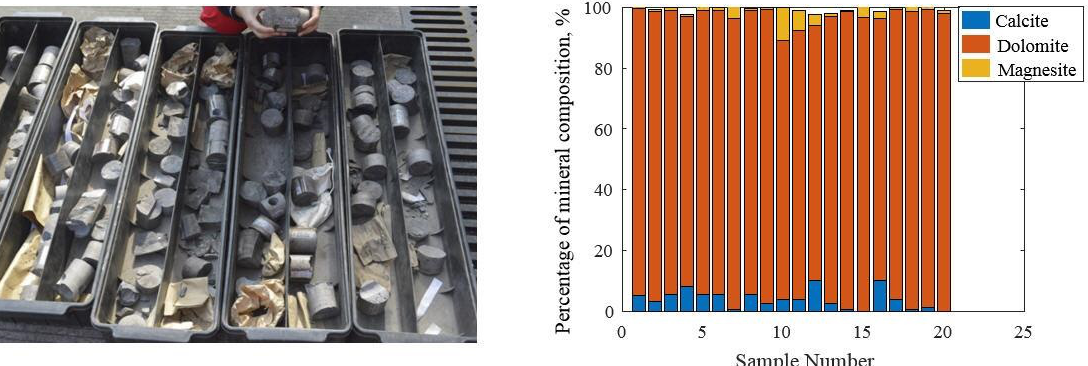
Figure 2. Photos of full-diameter cores and mineral